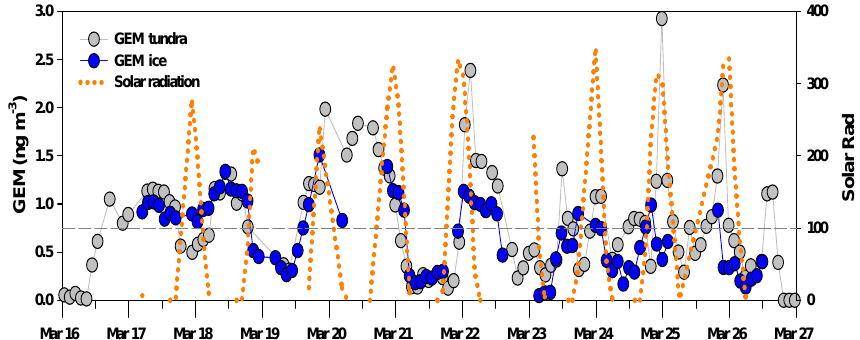
Fig. 6. GEM measurements over tundra inland (grey circles), over the sea ice (blue circles), solar radiation (orange) and the defined threshold for mercury depletions (0.77ngm − 3 ) (dashed grey